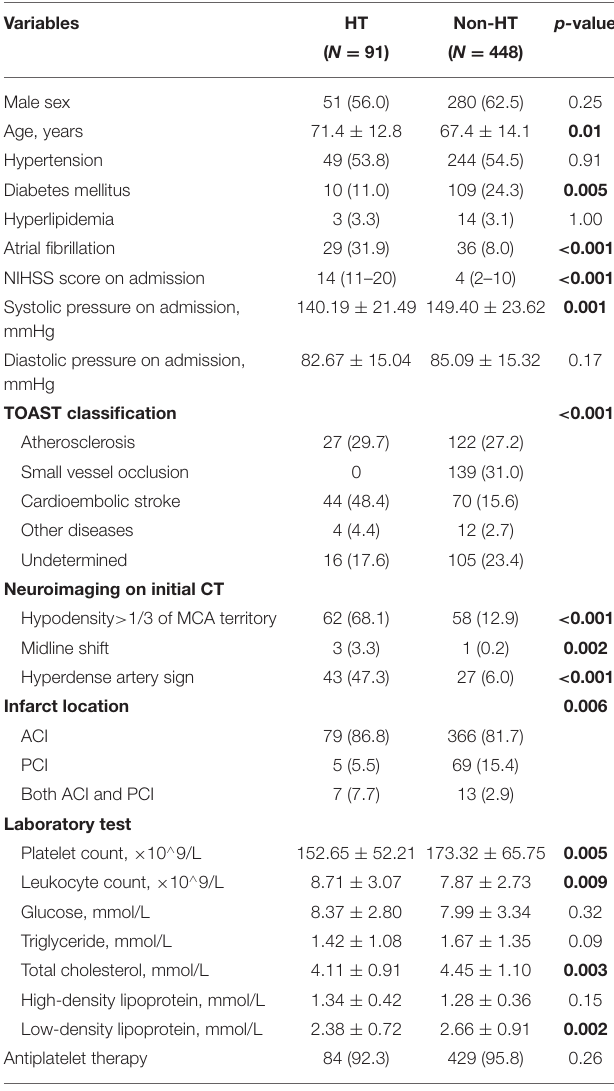
TABLE 1 | Characteristics of patients in the derivation and validation cohorts. Characteristics